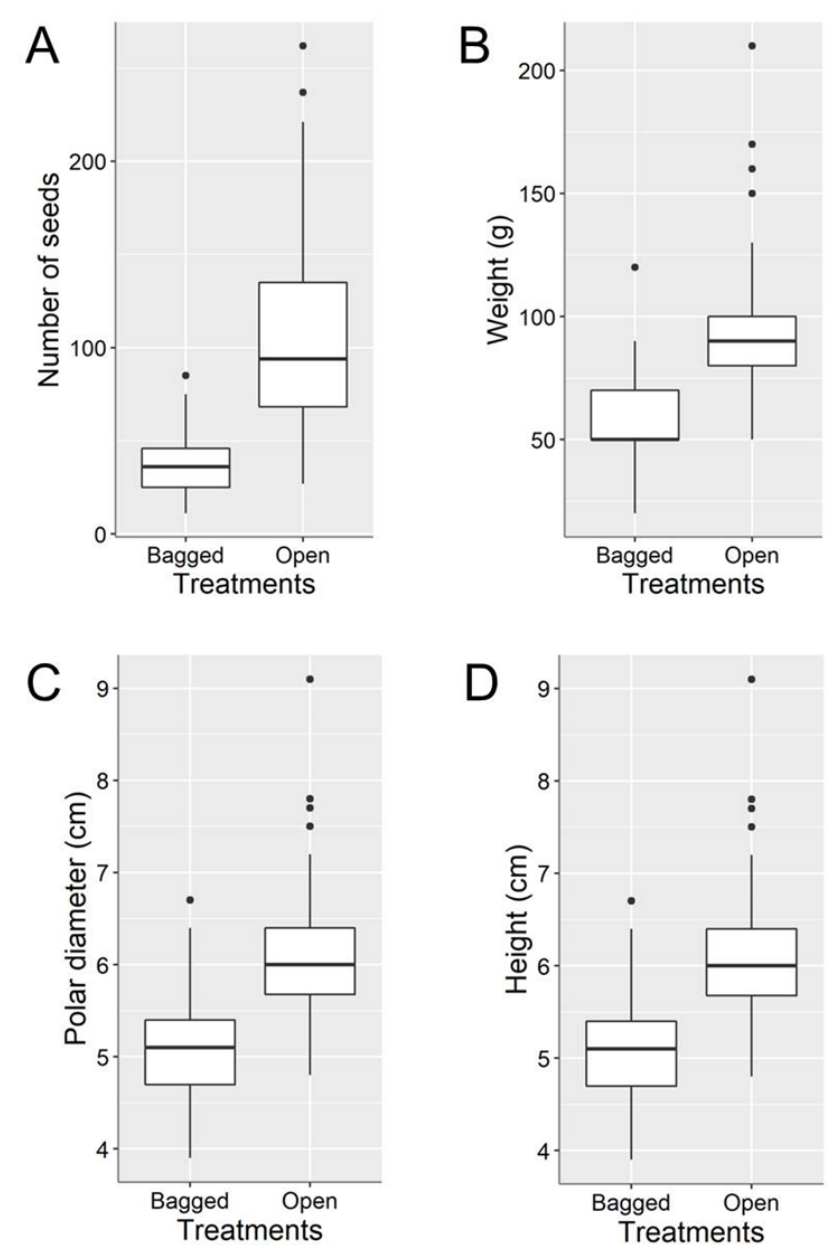
Figure 3. Fruit features of tomatoes obtained from open pollinated flowers and bagged flowers. The boxes depict the mean, 25th, and 75th percentiles. Black dots indicate